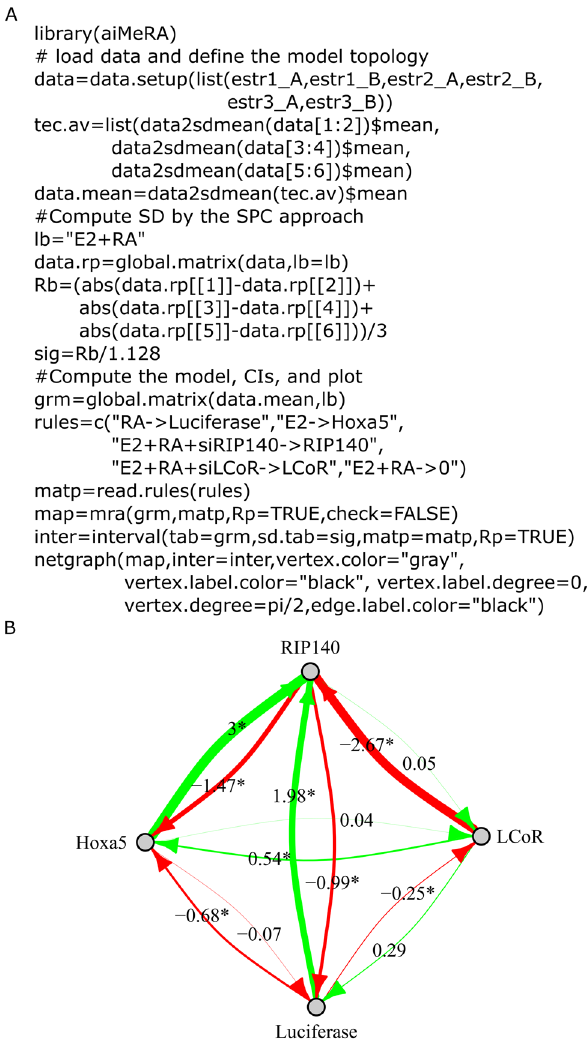
Figure 5. The aiMeRA R package. ( A ) Example R code for loading data, data preparation, and inference of a network. Note that NRIP1 was named by its common alternative name RIP140. Basal condition is E2 & RA stimulation (denoted “E2 + RA- > 0”) and LCoR perturbation is defined as “E2 + RA + siLCoR- > LCoR”. Same logic for RIP140 (= NRIP1). Perturbation on the HOXA5 module reporting RARs activity is defined as E2, i.e. , loss of RA stimulation compared to the basal condition was E2 & RA. Perturbation on the luciferase module is similarly defined as RA, i.e. , loss of E2. ( B ) Direct plot of an MRA-inferred network in R using the igraph library. Figure created with Inkscape 0.92 (www. inksc ape. org) and R 3.6